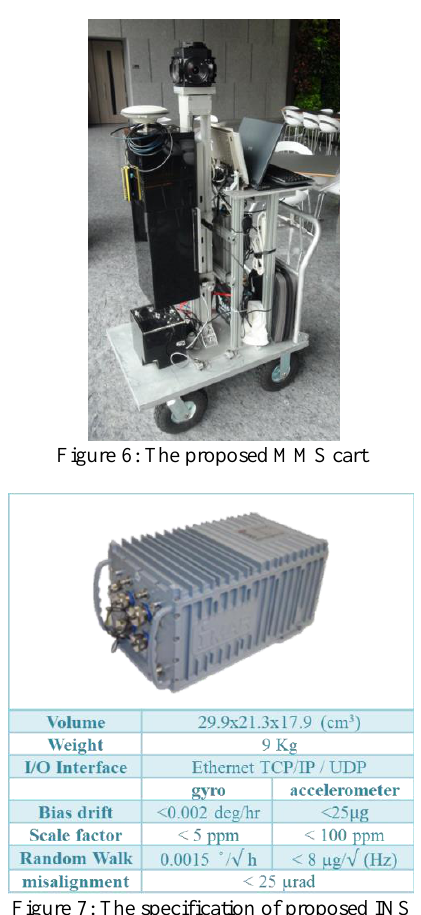
Figure 7: The specification of proposed